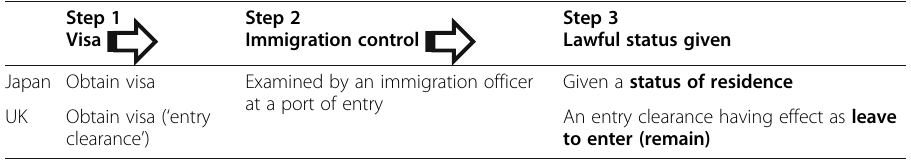
Table 2 visa and entry process in Japan and the UK Step 1 Visa